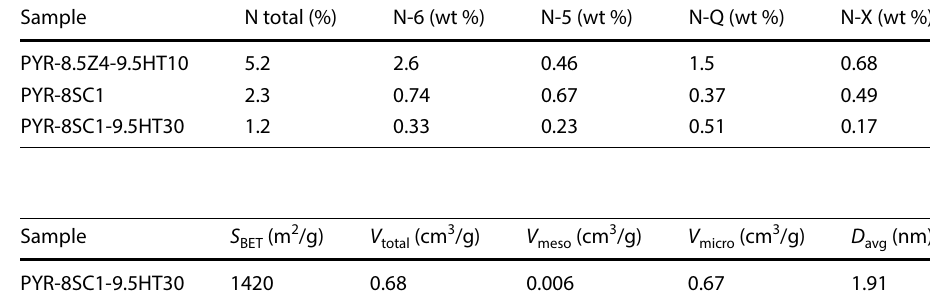
Table 2 N species (N1s) of samples determined by elemental analysis and XPS measurement